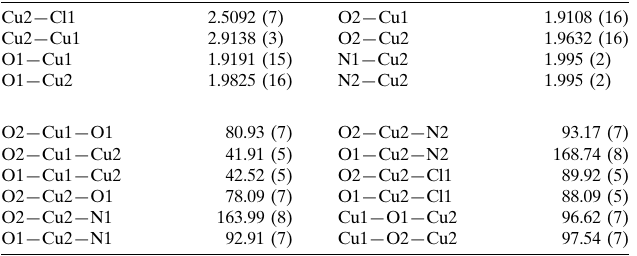
Selected geometric parameters (A˚ , (cid:2)